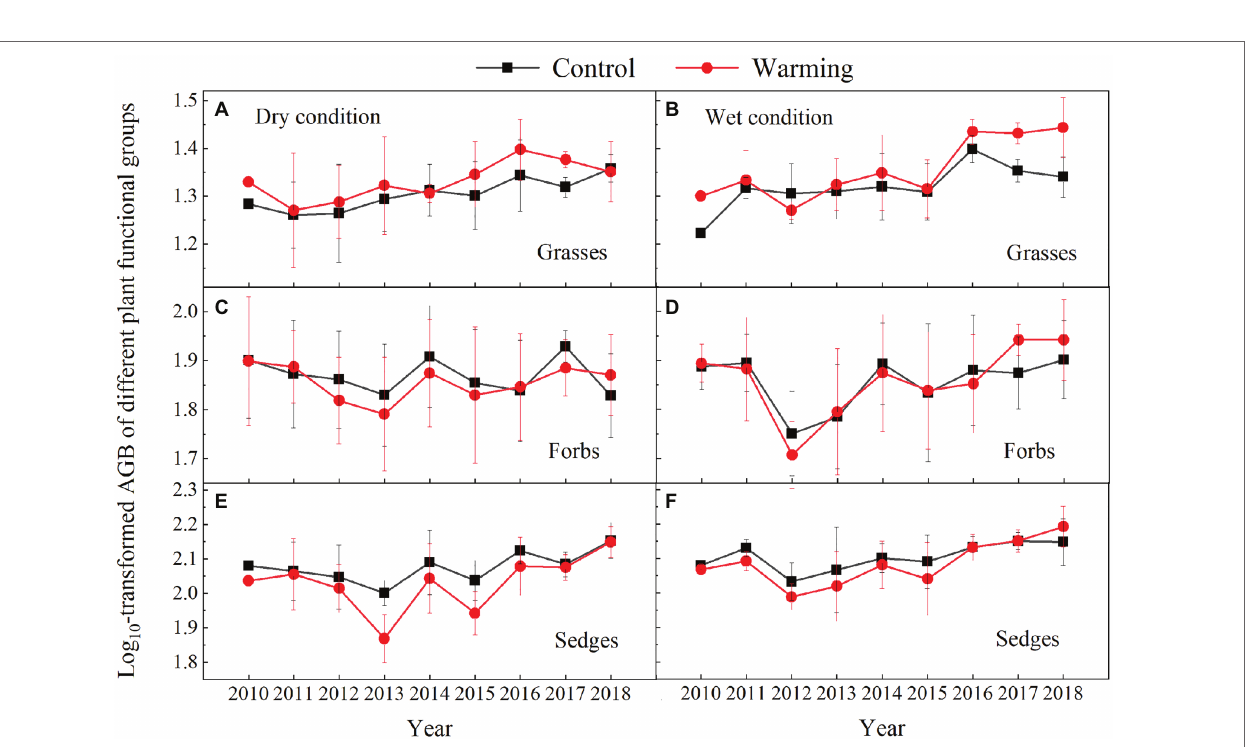
FIGURE 4 | Mean August and annual soil moisture at 0–10 cm and 30–40 cm depth in control and warmed plots in the dry (A,B) and wet (C,D) conditions from 2010 to 2018. Significance: * p < 0.05.